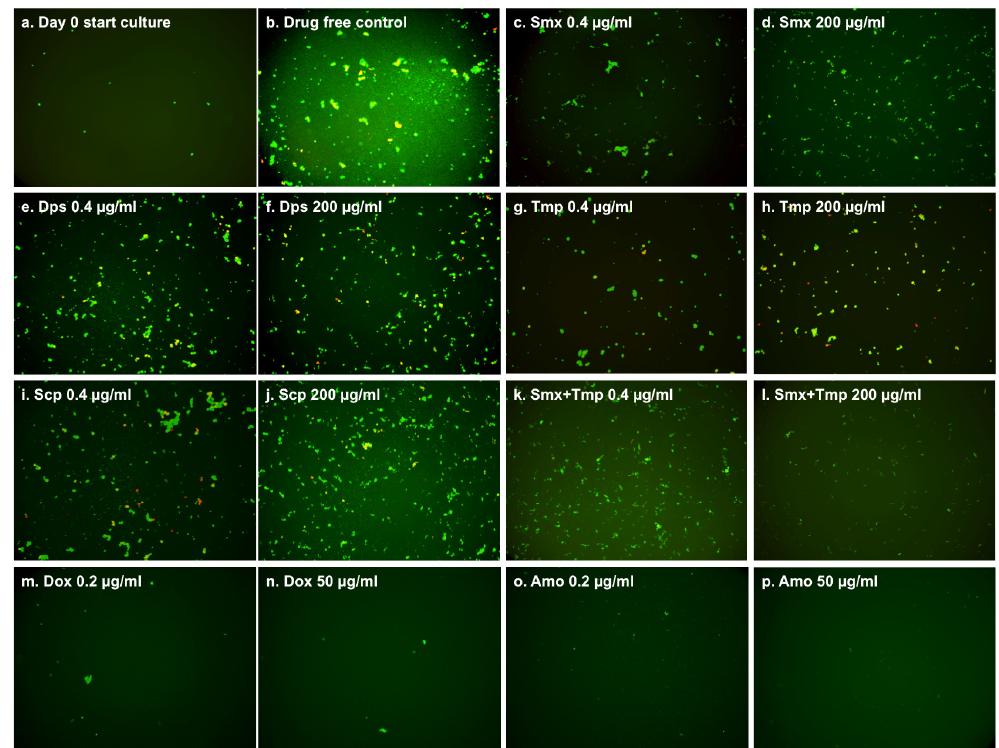
Figure 3. Effect of antibiotics on growing B. burgdorferi culture (five days old). The 10 4 spirochetes in 90 µ L fresh BSK-H medium as start culture ( a ) were incubated in 96-well microplate at 33 ◦ C and 5% CO 2 . The 10 µ L two-fold diluted antibiotics (200 µ g/mL to 0.4 µ g/mL) ( c – l ) and 10 µ l DMSO as the drug-free control ( b ) were added to the start culture. After a five-day incubation, the cell proliferation of every well was assessed using the SYBR Green I/PI assay and BZ-X710 All-in-One fluorescence microscope (KEYENCE, Inc., Itasca, IL,